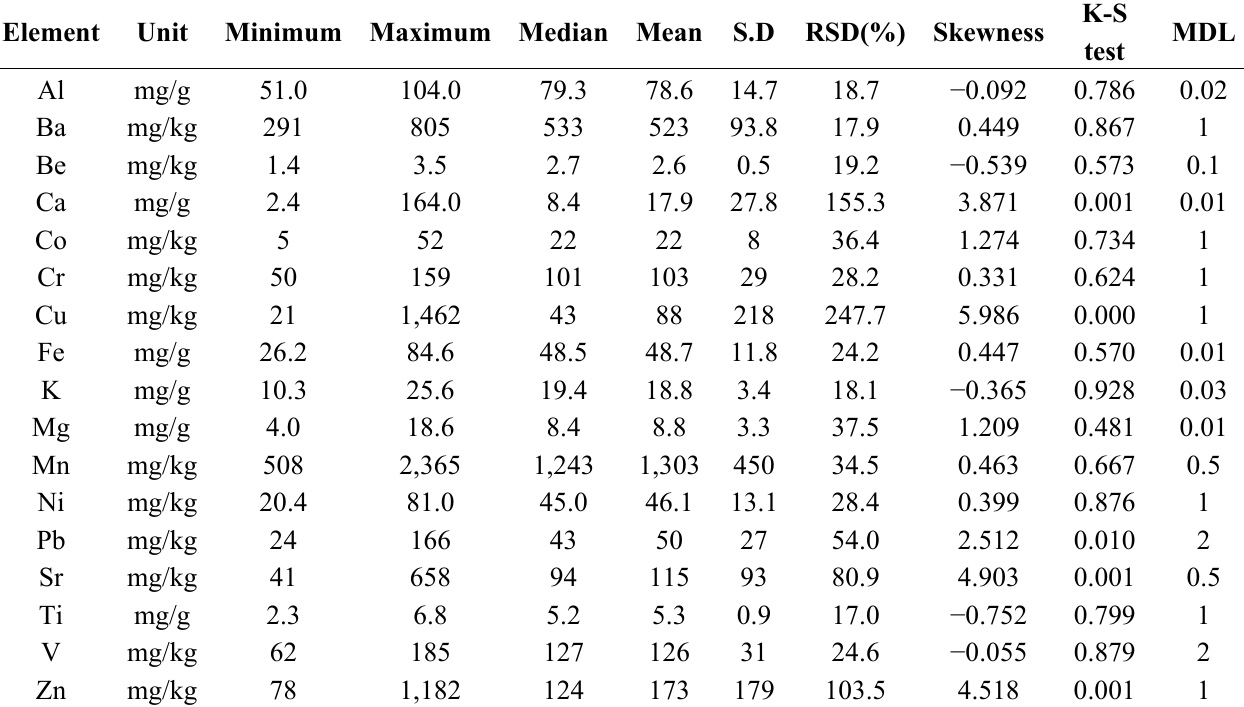
Table 1. Metal concentrations of lake sediments along the middle and lower reaches of Yangtze River.